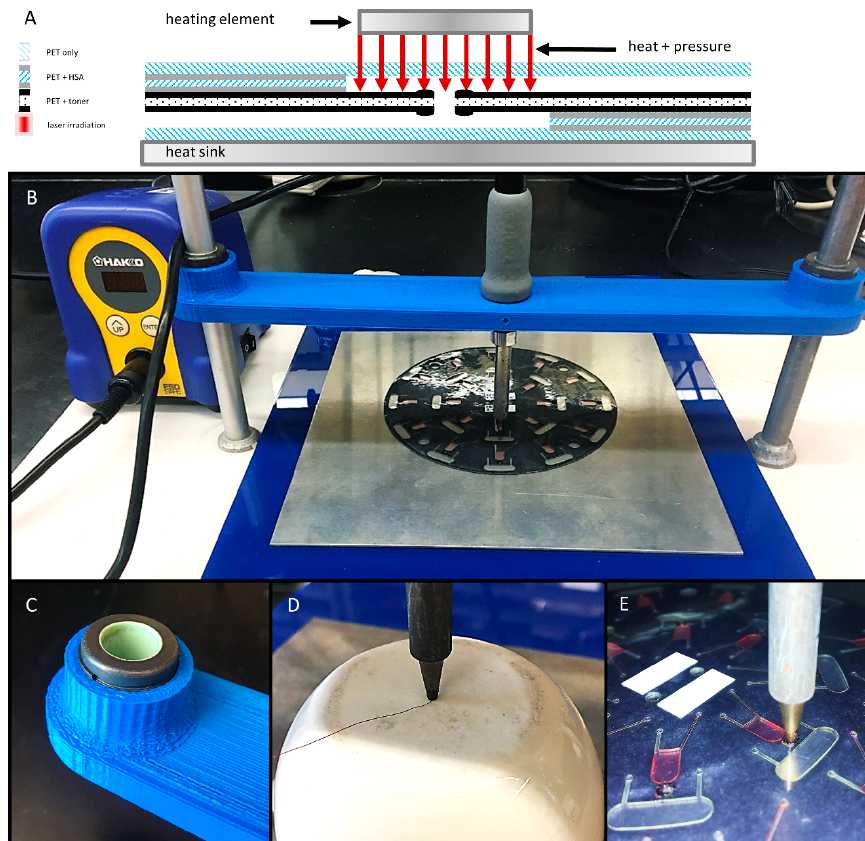
Figure 3. Schematic diagram and photographs of the gantry platform for bringing the heating element into contact with the disc. ( A ) Schematic diagram of the contact heating approach. ( B ) A gantry arm was 3D printed, outfitted with two self-aligning linear sleeve bearings ( C ), and suspended between two standard laboratory support stands. The soldering stylus was inserted into the gantry arm, held in place with set screws, and connected to the adjustable power supply. ( D ) Calibration of stylus temperature with a digital thermometer and a T-type thermocouple. ( E ) Close-up photograph of the soldering stylus in contact with a previously opened laser valve (2 × 2 mm).